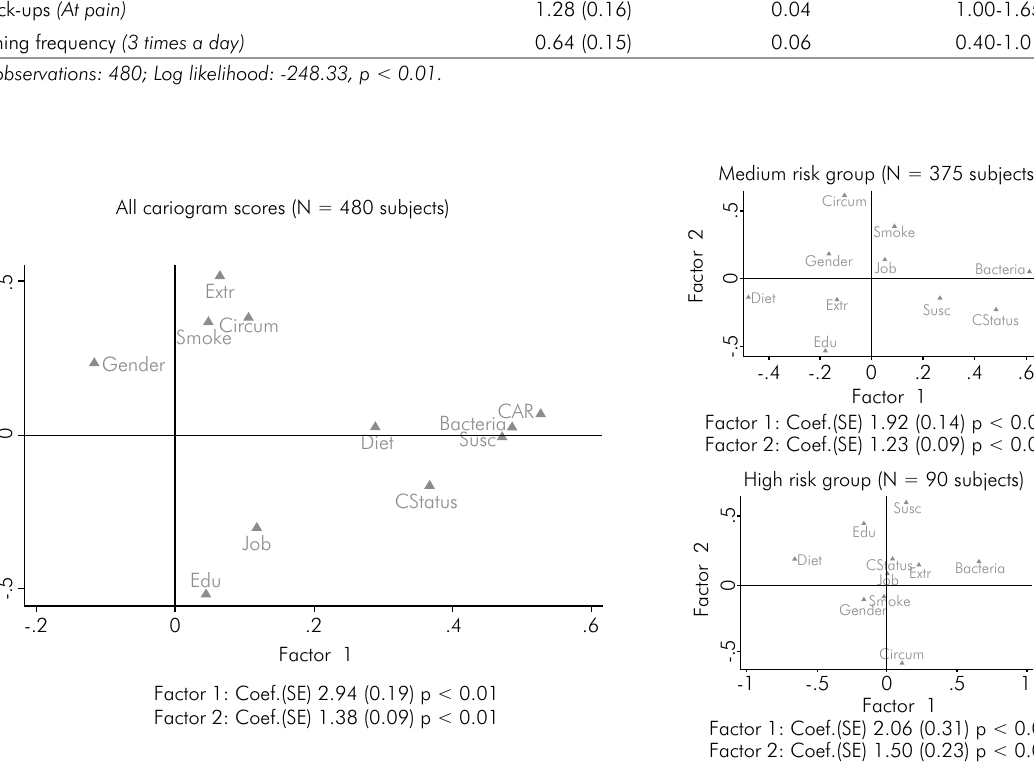
Figure 2. Principal Component Analysis. Orthogonal rotation (varimax).